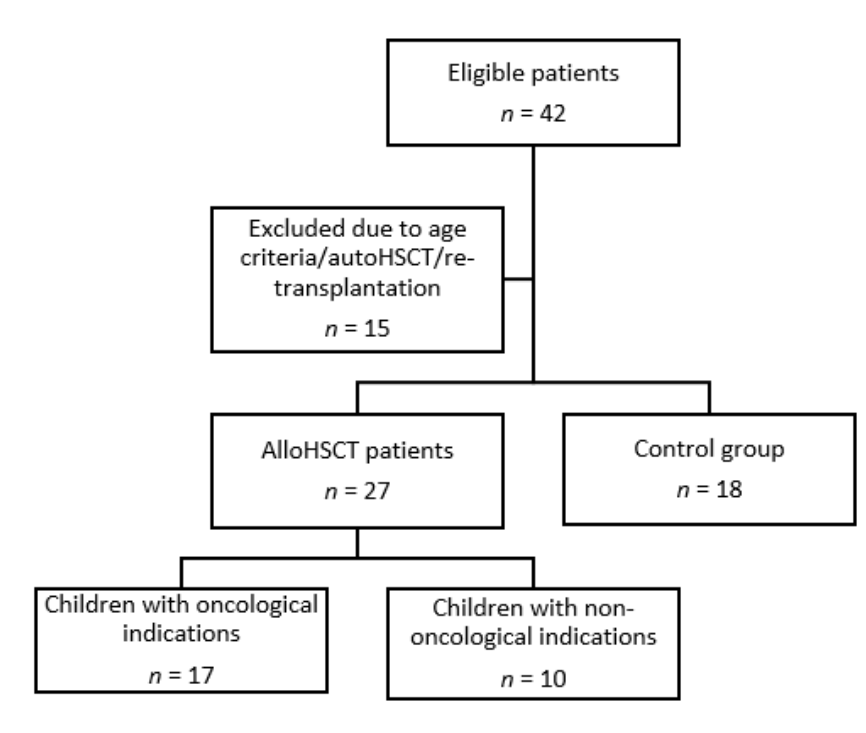
Figure 1. Patient